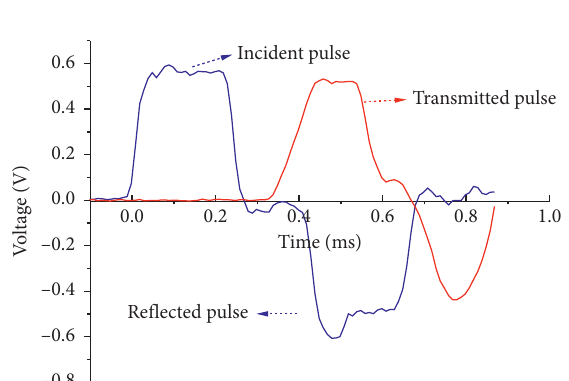
Figure 7: The typical waveforms of the samples.